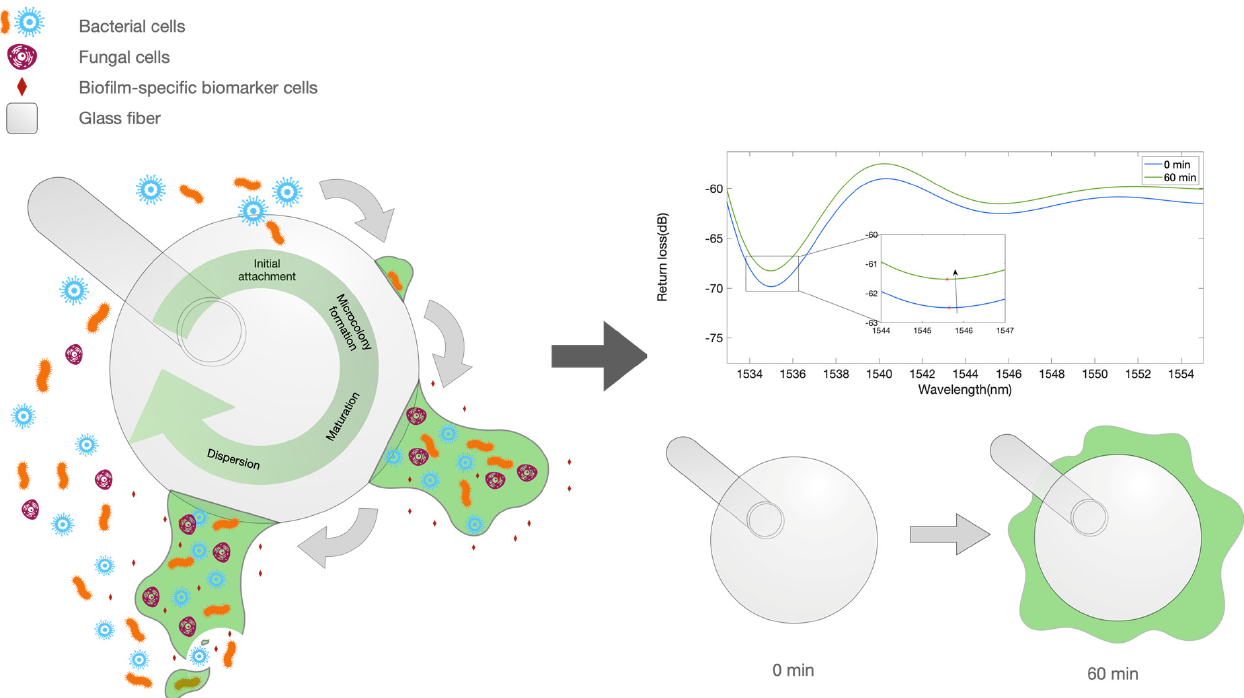
Figure 1. Illustration depicting the biofilm formation and biofilm markers. Left: artwork describing the process of biofilm formation on the surface of an optical fiber spherical tip used as biosensor. Right: equivalent optical model for the early stage growth, showing a ball resonator surrounded by a medium with a varying refractive index.